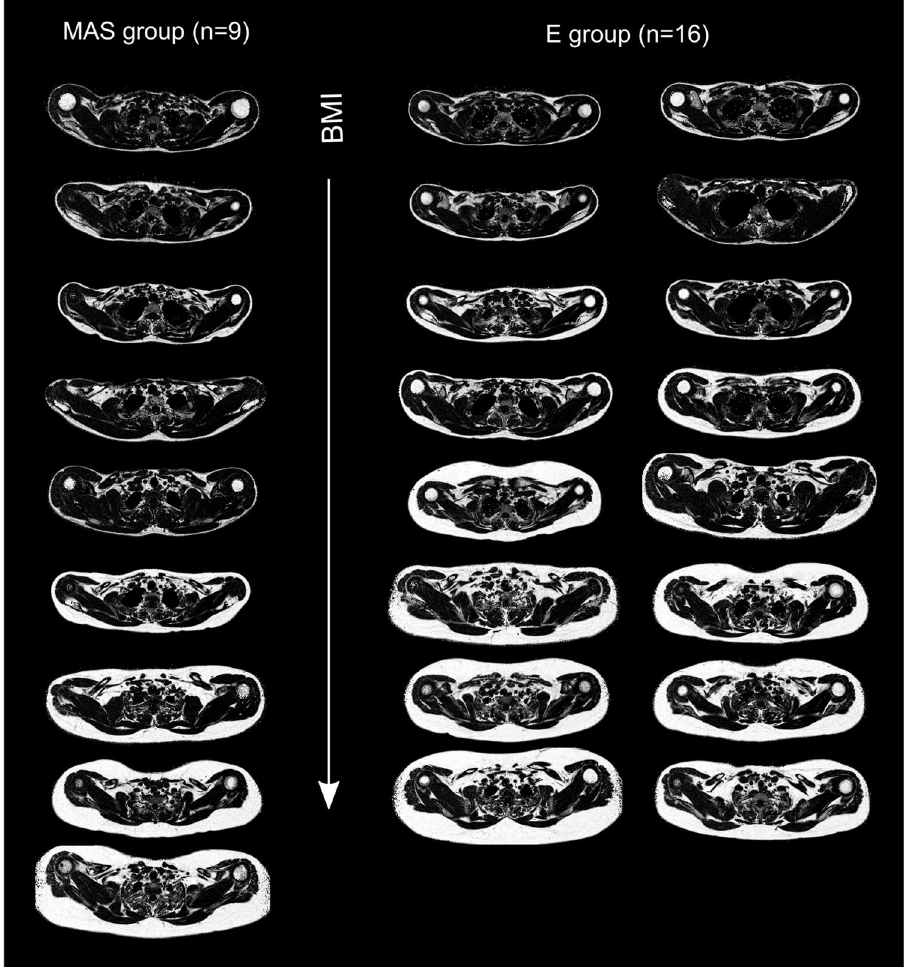
Figure 2. Axial fat fraction (FF) maps of the subjects in the multi-atlas segmentation (MAS) group and the evaluation (E) group. Both groups were composed of adults and children with body compositions ranging from lean to obese, here ordered according to